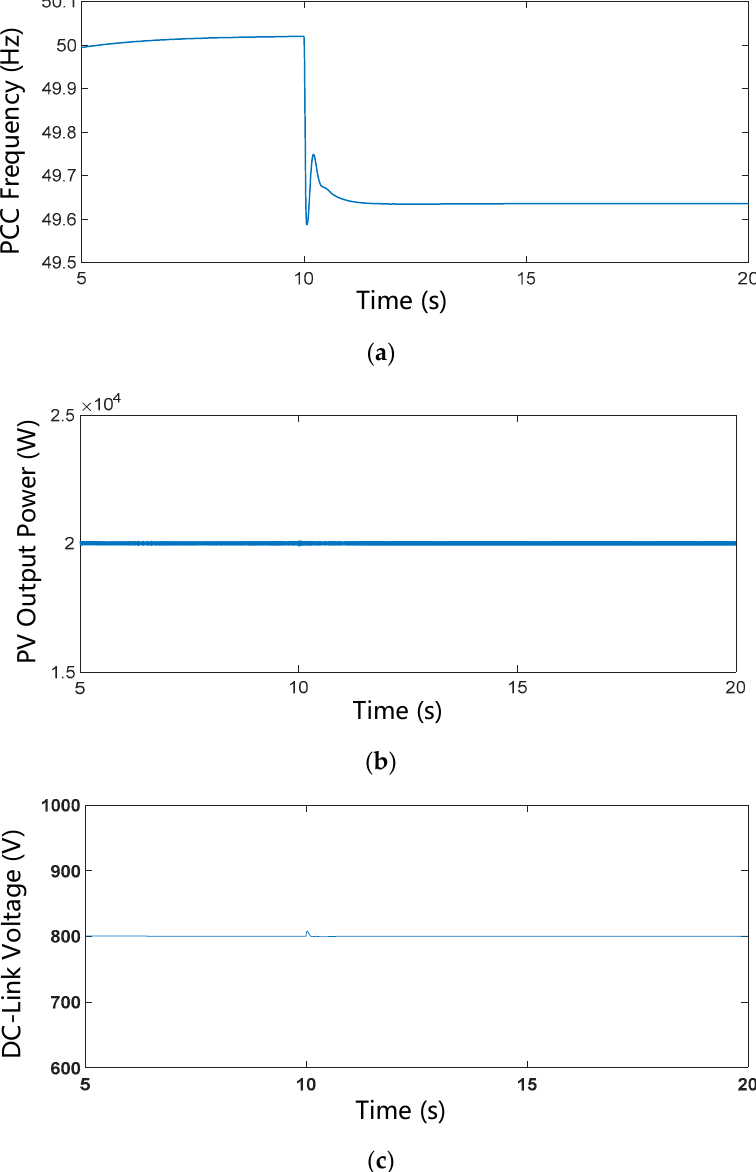
Figure 10. Simulation results of the traditional PV control method: ( a ) PCC frequency, ( b ) PV output power, and ( c ) DC-link voltage.